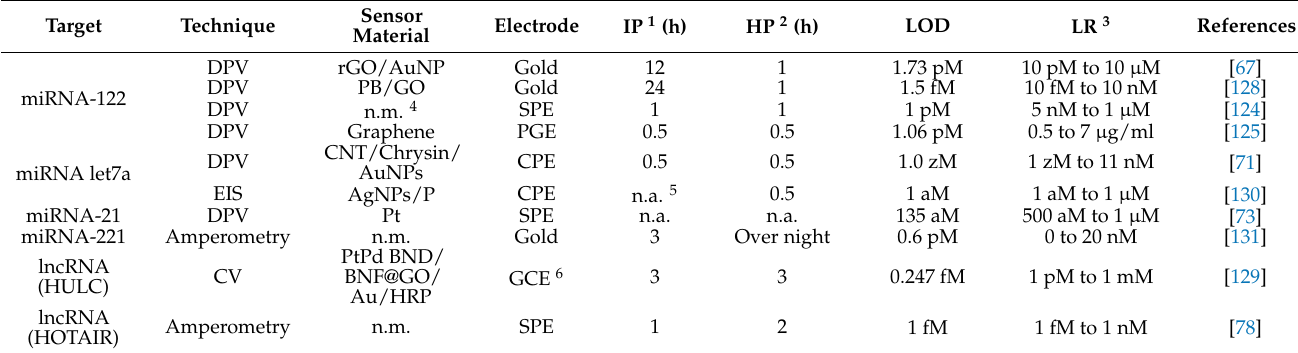
Table 2. Summary of introduced electrochemical biosensors for liver cancer-related ncRNA detection. Target